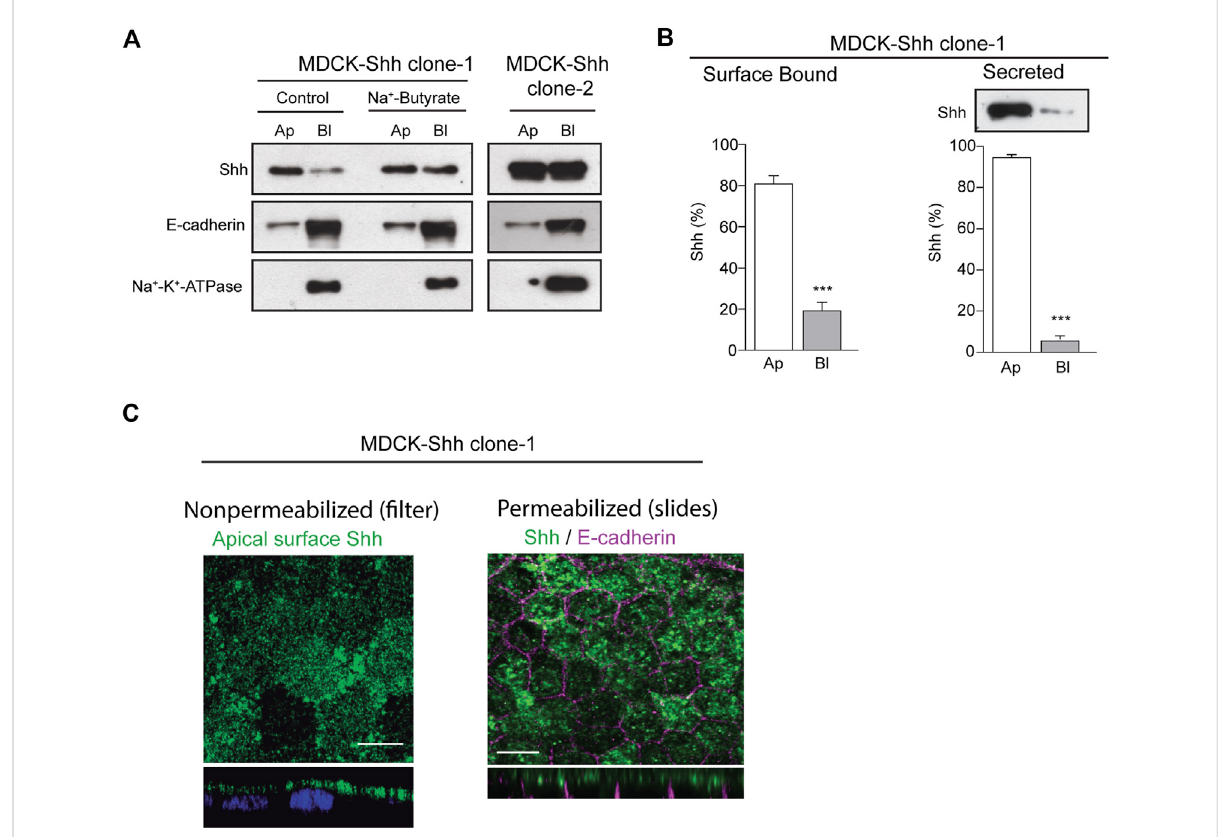
FIGURE 1 Shh is apically distributed and secreted in stable transfected MDCK cells. (A) Domain-selective biotinylation of stable transfected MDCK-Shh grown in Transwell fi lters. MDCK-Shh clone-1 shows Shh mainly at the apical cell surface, changing to non-polarized when cells are treated with 2 mM Na + -butyrate for 24 h to increase Shh expression. MDCK-Shh clone-2 expressing higher Shh levels than clone-1 displays Shh equally distributed among the apical and basolateral cell surface. E-cadherin and Na + /K + -ATPase basolateral distribution corroborates the polarized statusofthecells. (B) Graphsshow~80%apicalcellsurfacedistribution(n=6)andmorethan90%apicalsecretionofShhin6 hconditionedmediain MDCK-Shh clone-1 (n = 3), (*** p < 0.001); (C) Polarized MDCK-Shh clone 1 cells immunostained for apical cell surface Shh in non-permeabilized cells grown in fi lters, as well as for total Shh (green) and E-cadherin (magenta) in cells grown in glass coverslips, as indicated. Images are confocal z-stacks maximum projections. Scale bar, 10 μ